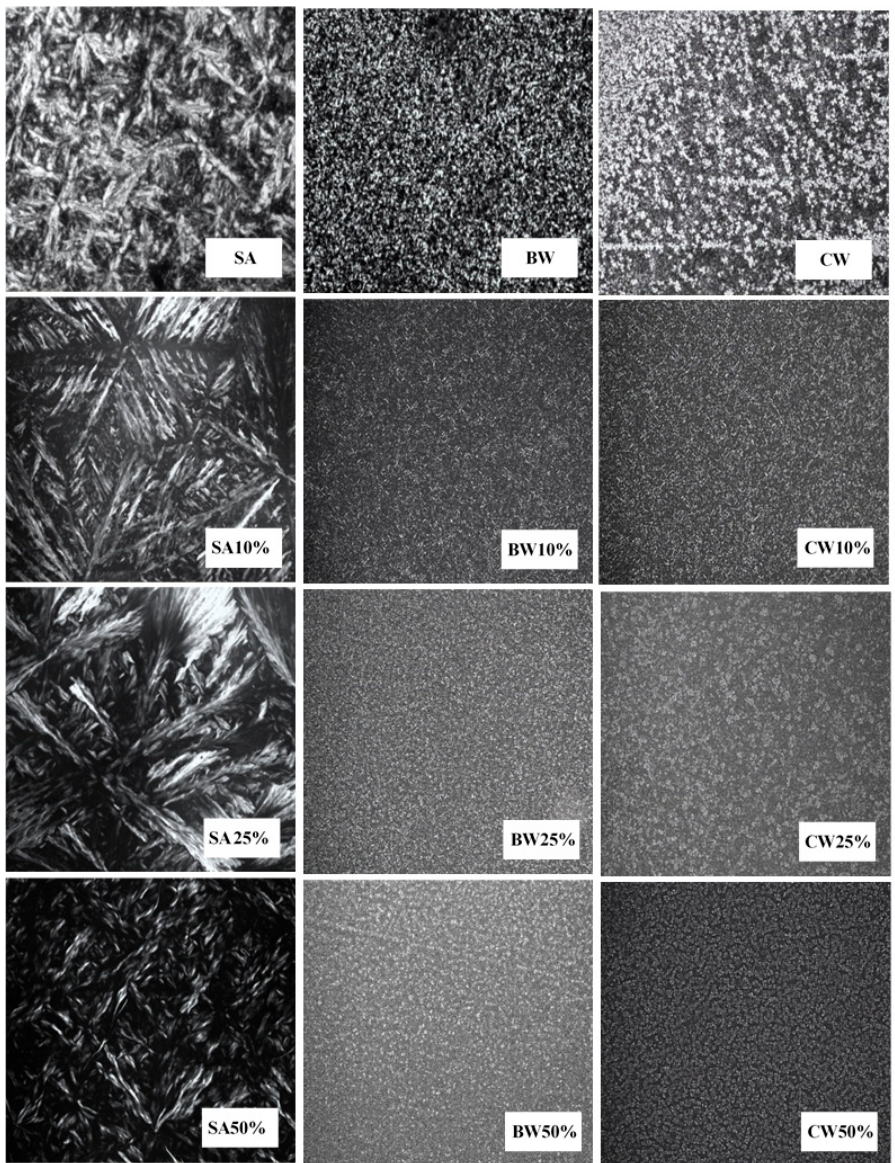
Figure 6. Optical micrographs produced with polarized light microscopy at room temperature corresponding to stearic acid, beeswax, carnauba wax and their binary mixtures containing 10%, 25% and 50% of carvacrol. Images obtained using 10 × magnification.